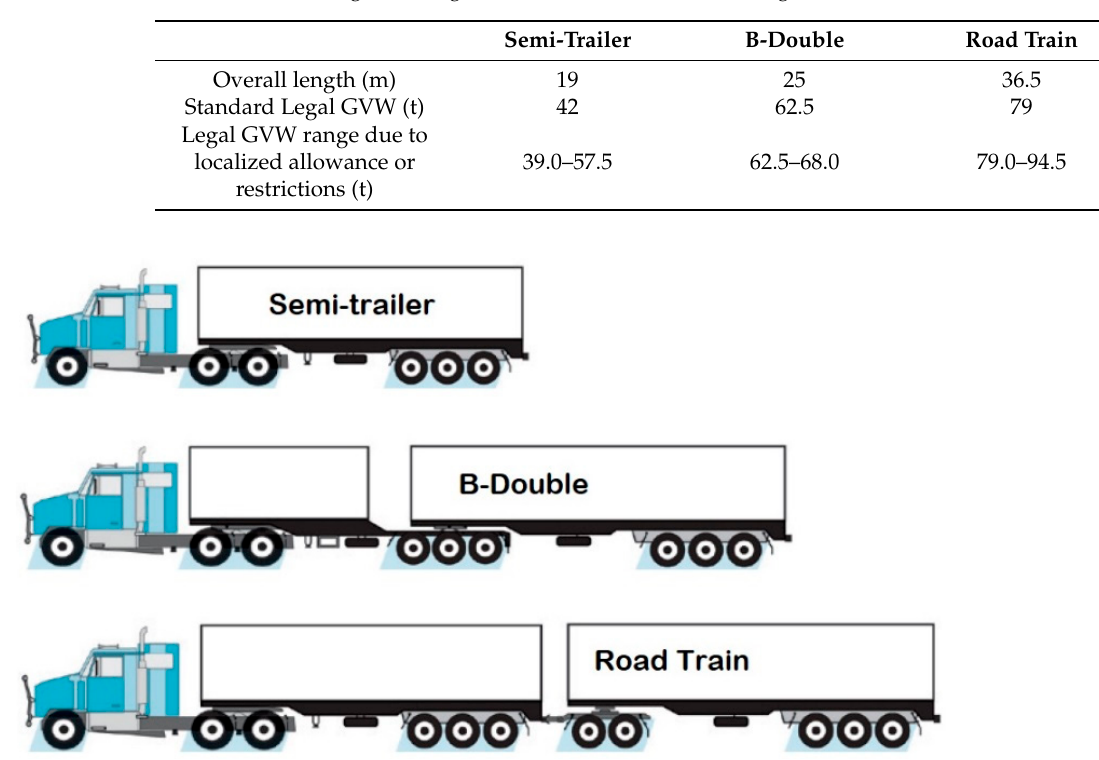
Figure 1. Vehicle configuration Figure 1 . Vehicle configuration descriptions .